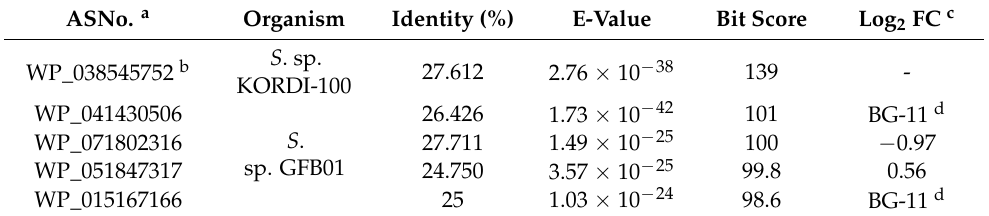
Table 2. Sequences homologous to Bacillus amyloliquefaciens Aspartate aminotransferase protein, coded by GabT1, found in Synechococcus sp. GFB01 in the current proteomic analysis. ASNo.